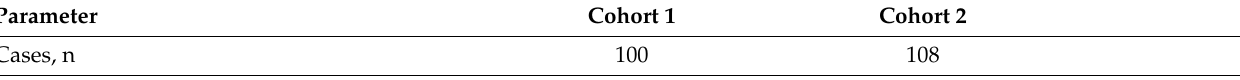
Table 2. Outcomes of radical